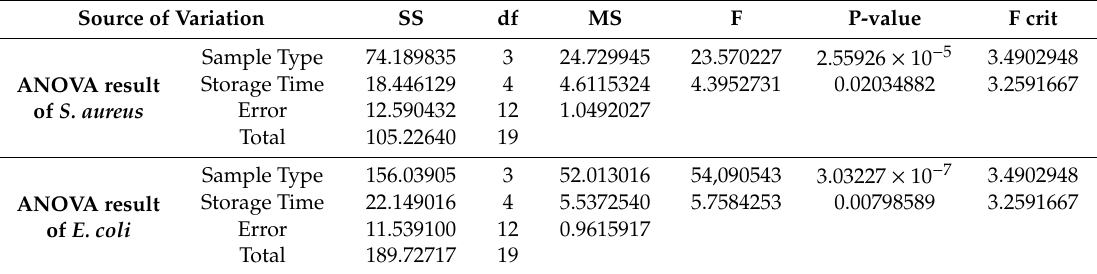
Table A2. ANOVA analysis of antimicrobial test result over storage time: plasma treated wipe samples. Source of Variation SS df MS F P-value F crit ANOVA result of S. aureus